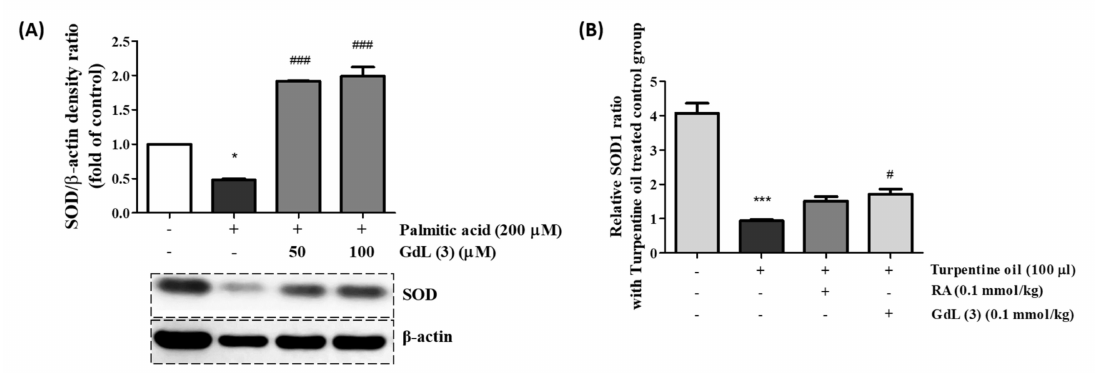
Figure 6. The e ffi cacy of the GdL (3) treatment on the super oxide dismutase (SOD) expression in ( A ) PA-induced C2C12 cells and ( B ) turpentine oil-induced inflammatory tissue. * p < 0.05 and *** p < 0.001, significant di ff erence from the control. ### p < 0.001, significant di ff erence from the group of PA-induced cells (n = 4) and # p < 0.01, significant di ff erence from the group of only turpentine oil-treated mice (n =